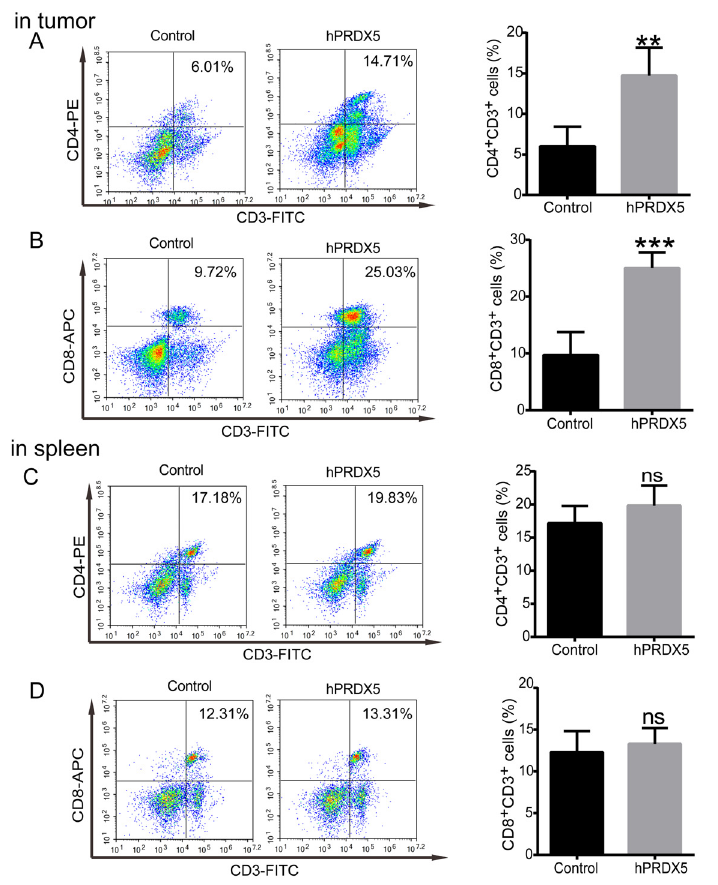
Figure 2. Effect of human peroxiredoxin-5 (hPRDX5) on the proportion of T cells in tumor and spleen tissues of mice. Proportion of CD3 + CD4 + T cells ( A ) and CD3 + CD8 + Tcells ( B ) in tumor tissues and of CD3 + CD4 + Tcells ( C ) and CD3 + CD8 + Tcells ( D ) in spleen tissues in the control and hPRDX5 treatment groups. Data are reported as means ± SD. **P o 0.01 and ***P o 0.001 compared with the control ( t -test). ns: not signi fi